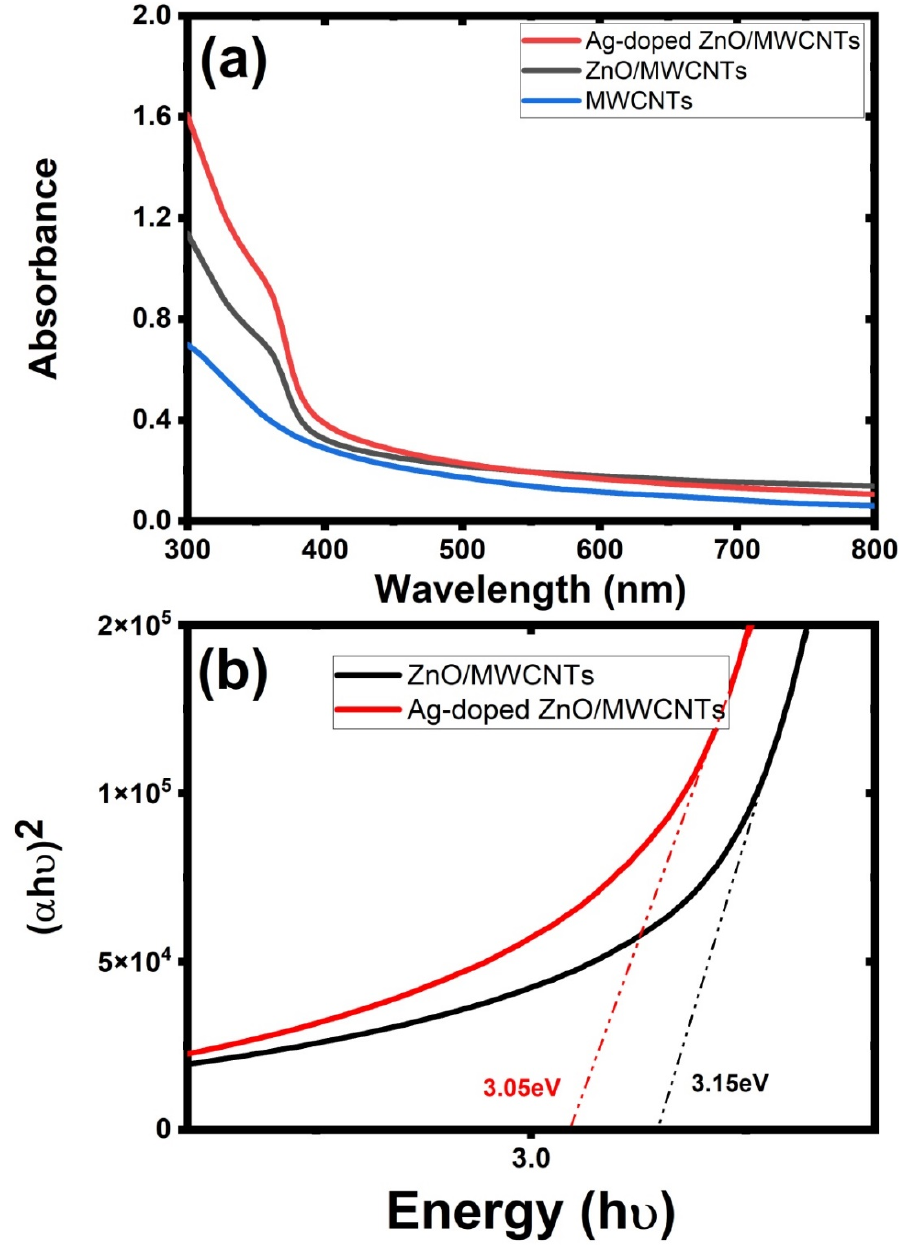
Figure 5. ( a ) Absorption spectrum of MWCNTs, ZnO/MWCNTs, and Ag-doped ZnO/MWCNTs nanocomposite and ( b ) their energy transition via Tauc